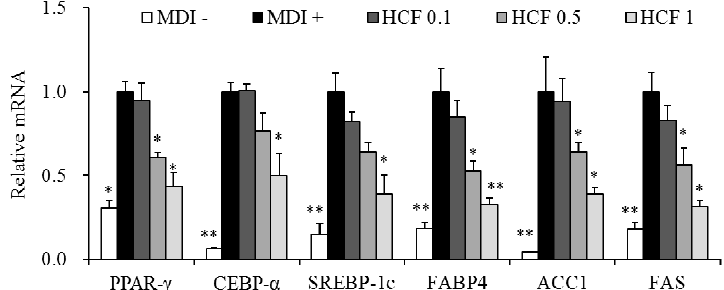
Figure 5. Effects of HCF on mRNA expression of adipocyte-specific genes in adipocytes. The 3T3-L1 cells were treated with 0 (MDI—treated control, MDI +), 0.1, 0.5 or 1 µg/mL HCF for 7 days. Preadipocytes without MDI media (MDI -) were used for baseline. The mRNA levels of PPAR- γ , CEBP- α , SREBP-1c, FABP4, ACC1, and FAS were determined by real-time quantitative PCR. HCF, hot water extract of C. morifolium flower; PPAR- γ , peroxisome proliferator-activated receptor-gamma, CEBP- α , CCAAT / enhancer-binding protein-alpha, SREBP-1c, sterol regulatory element-binding protein-1c; FABP4, adipocyte fatty acid-binding protein 4; ACC1, acetyl-CoA carboxylase-1; FAS, fatty acid synthase; MDI, medium containing 3-isobutyl-1-methylxanthine, dexamethasone, and insulin. Values are expressed as mean ± standard error of three independent experiments. * p < 0.05